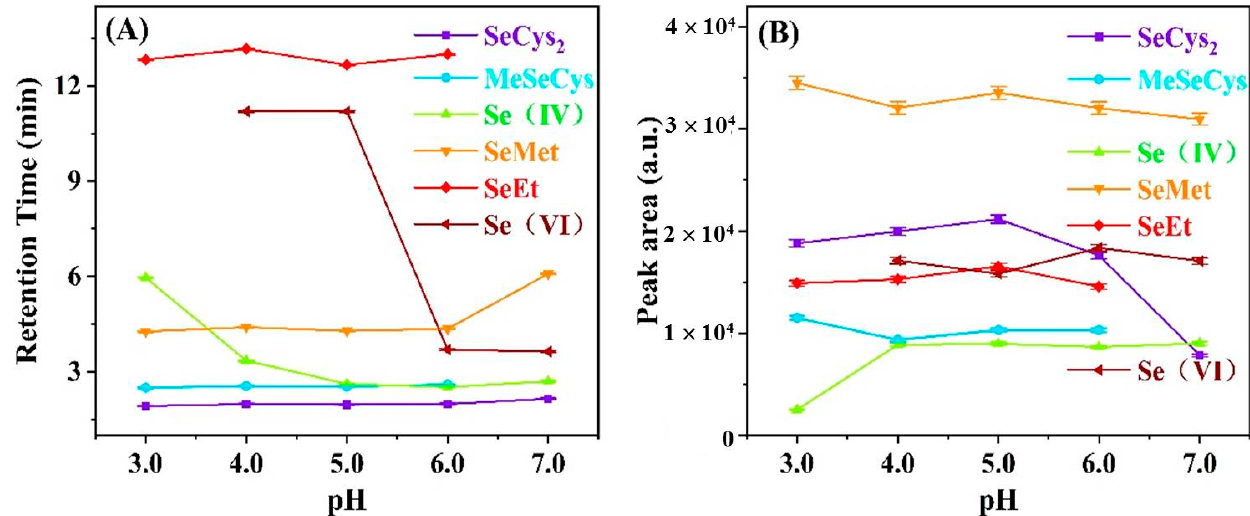
Figure 3. The effects of pH on the ( A ) retention time of Se species and ( B ) intensity.